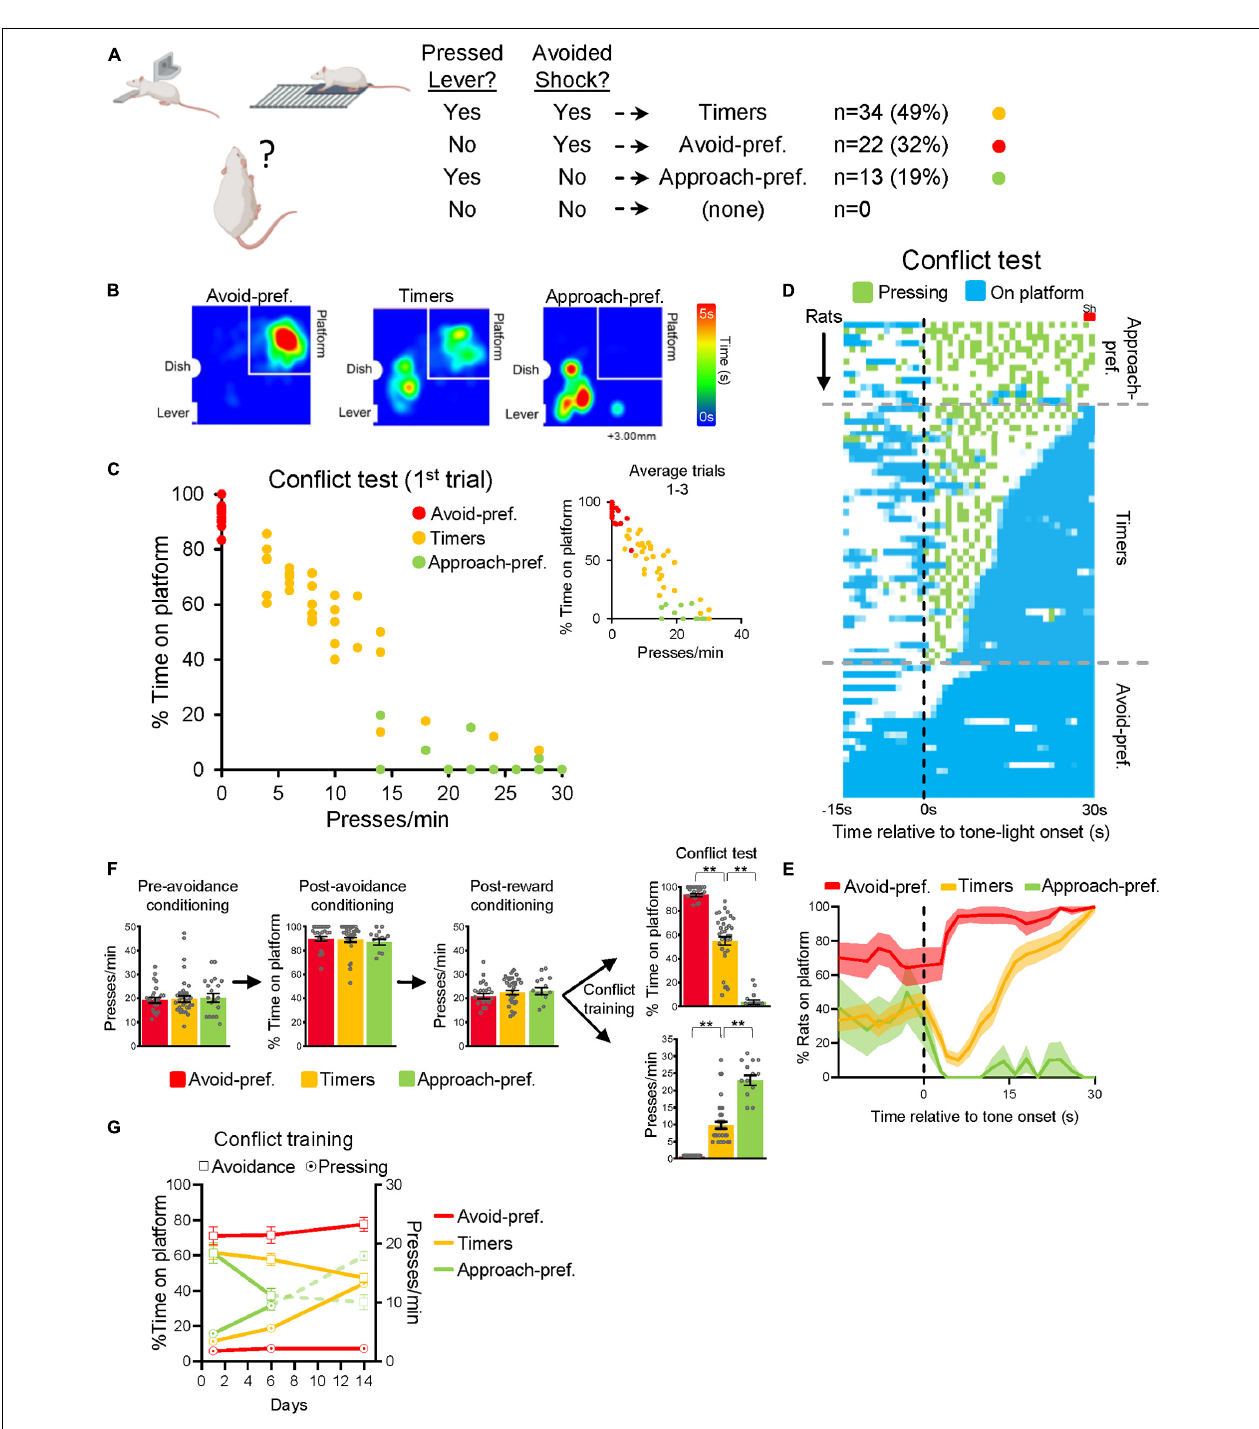
FIGURE 2 | Rats showed three distinct strategies for resolving approach-avoidance conflict. (A) Criteria for separating rats into different conflict strategies. Rats were separated into three subgroups: Avoidance-preferring (22/69 32%, red), Approach-preferring (13/69, 19%, green), and Timers (34/69, 49%, yellow). (B) Heat maps showing the location of rats during the conflict test ( n = 7 for each subgroup). (C) Presses/min vs. % time pressing for individual rats at conflict test trial 1, showing that the three subgroups were distinct from each other. Inset shows averaged data for all three trials of conflict test. (D) Actogram depicting each rat’s behavior during conflict test (bin = 1 s) across the conflict test. Subgroups are separated by horizontal dashed lines. (E) Average time spent on platform for each subgroup. (F) Averaged behaviors for each subgroup prior to, and following, conflict training. Subgroup differences were not apparent prior to conflict training. (G) Average time spent avoiding (square) and pressing (circle) during conflict training, for each subgroup. ** P < 0.01.